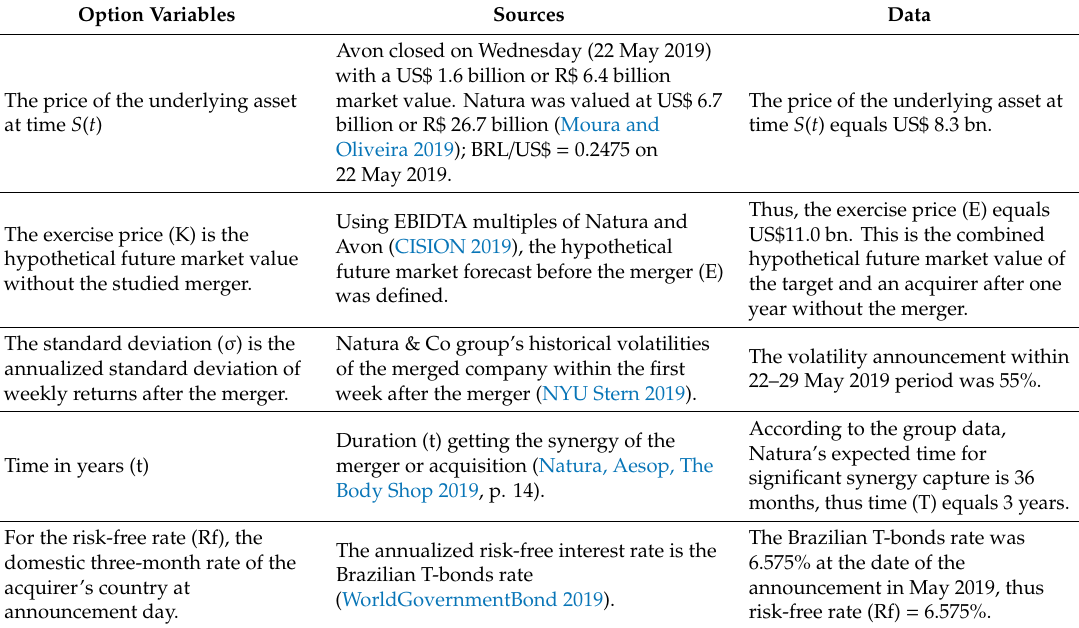
Table 9. Data and methodology to measure competence-based synergies of the Natura & Avon M&A deal with a real options